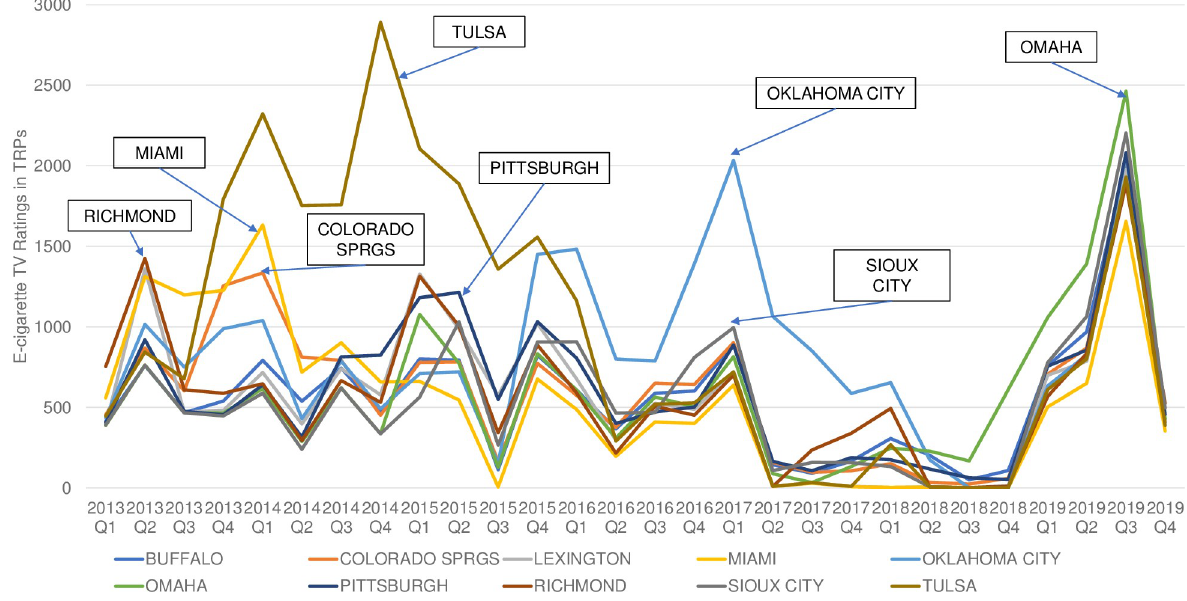
Fig 3. Adult (age 18 and above) quarterly e-cigarette TV target rating points (TRPs) by top 10 Nielsen retail market, 2013–2019.